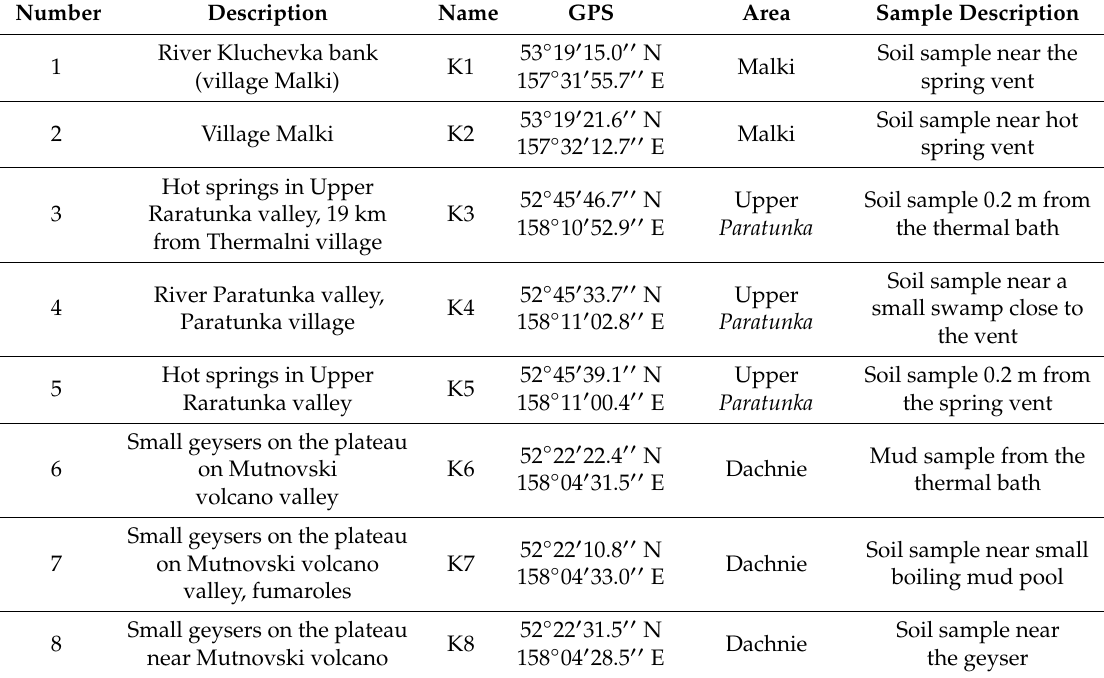
Table 2. Characteristics of the studied